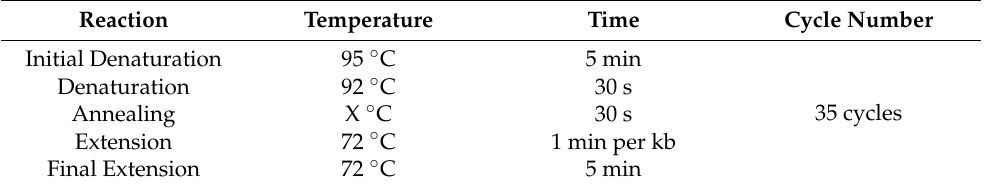
Table 2. Cycling conditions for genomic DNA amplification. Reaction